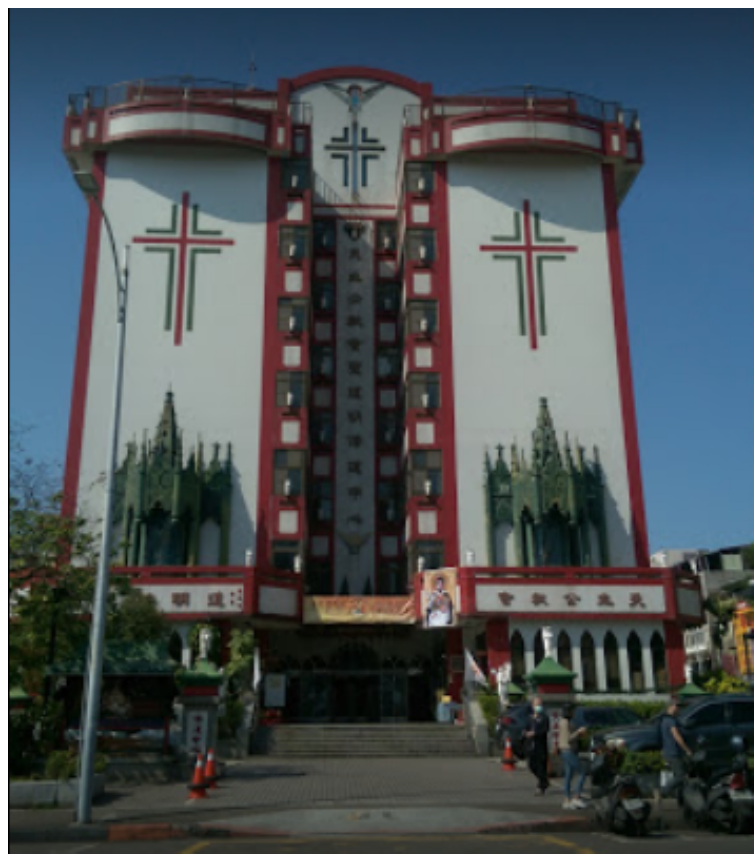
Figure 10. The church of Saint Dominic in Taipei 天 主 教 聖 道 明 傳 道 中 心 .